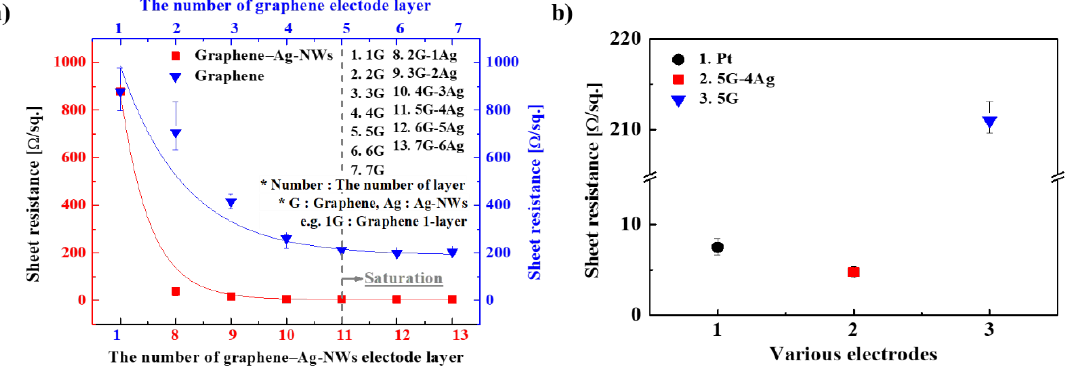
Figure 3. ( a ) Sheet resistance of graphene–Ag-NW composites and graphene according to the number of layers; ( b ) Sheet resistance Pt, 5G–4Ag, and 5G electrodes.